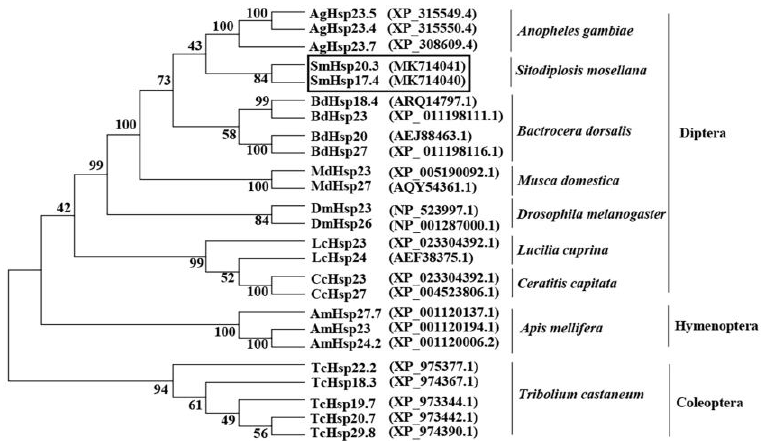
Figure 2. Phylogenetic relationship of SmHsp17.4 and SmHsp20.3 (boxed) as well as sHsps from other insects. The phylogenetic tree was built by the neighbor-joining method using MEGA 6.0 with 1000 bootstrap replications.